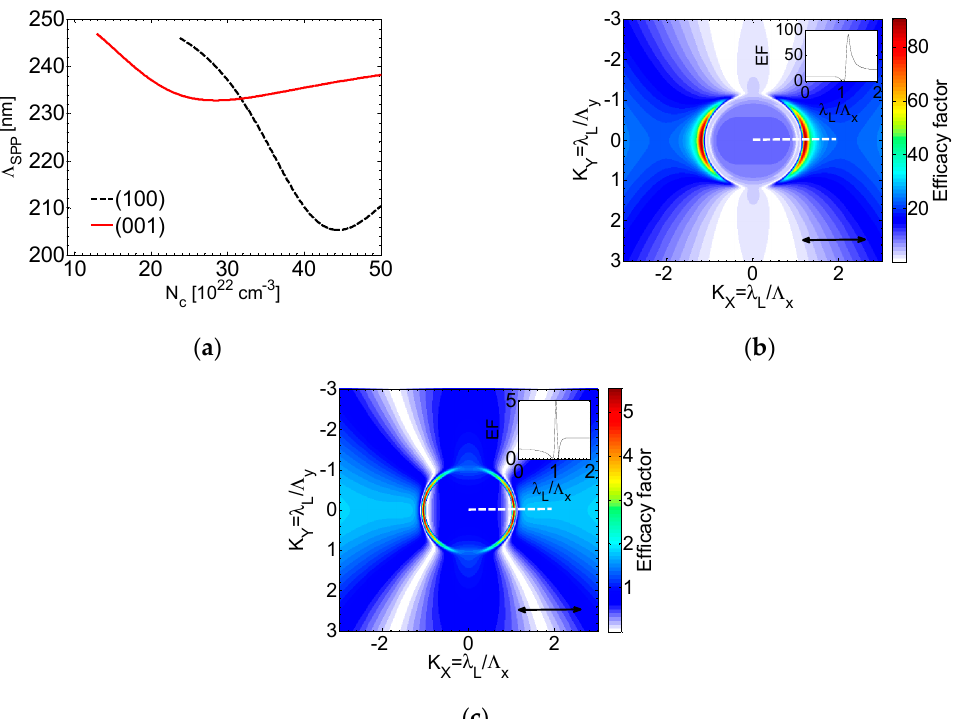
Figure 1. ( a ) Surface plasmon wavelength as a function of the excited carrier densities for (001) and (100) crystal orientation. Prediction of structure periodicity based on Sipe’s theory for ( b ) 44 × 10 22 cm − 3 (100) and ( c ) 27 × 10 22 cm − 3 (001). Inset shows the profile of the efficacy factor along K x ( white dashed line). The black double headed arrow indicates the direction of the polarisation vector.